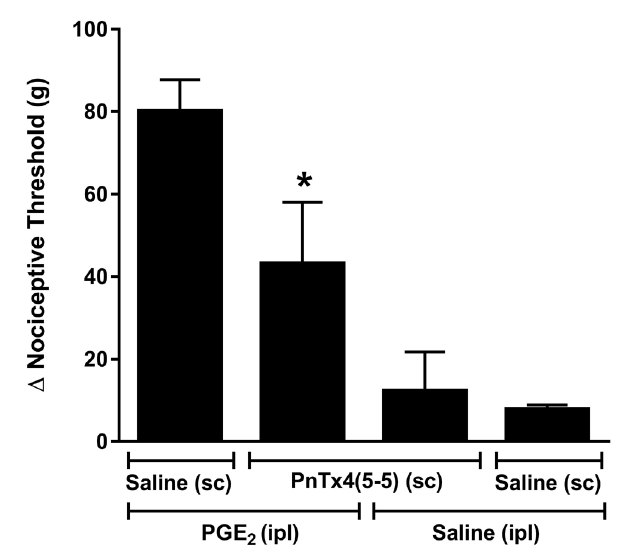
induced hyperalgesia. 2 (2 µg/paw). PnTx4(5-5) 2 . Each 2